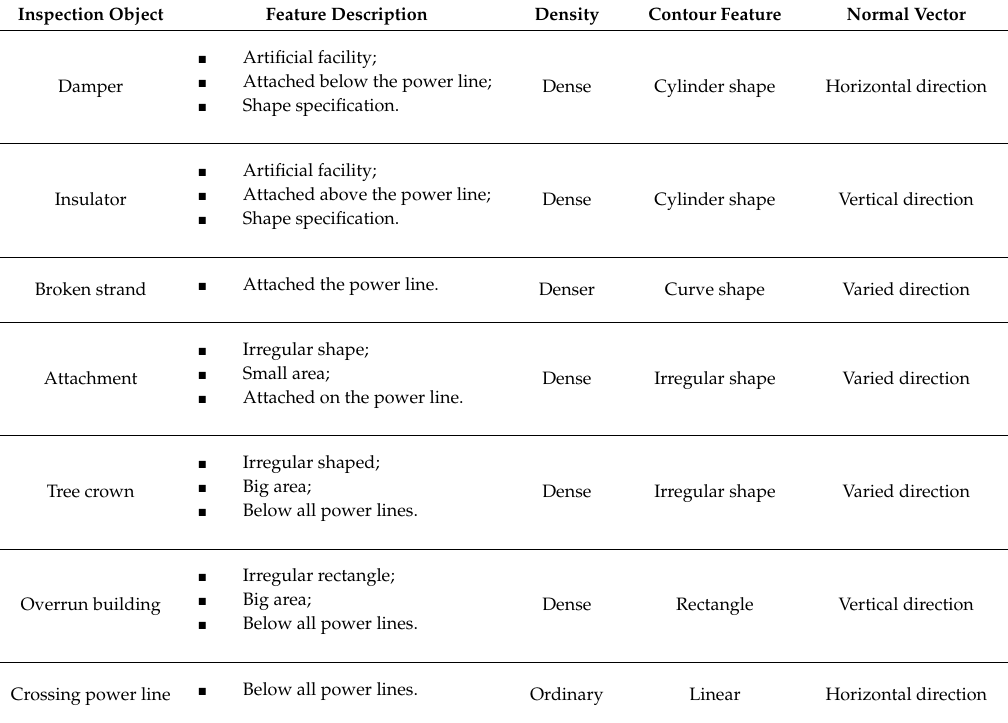
Table 1. Characteristic rules of inspection